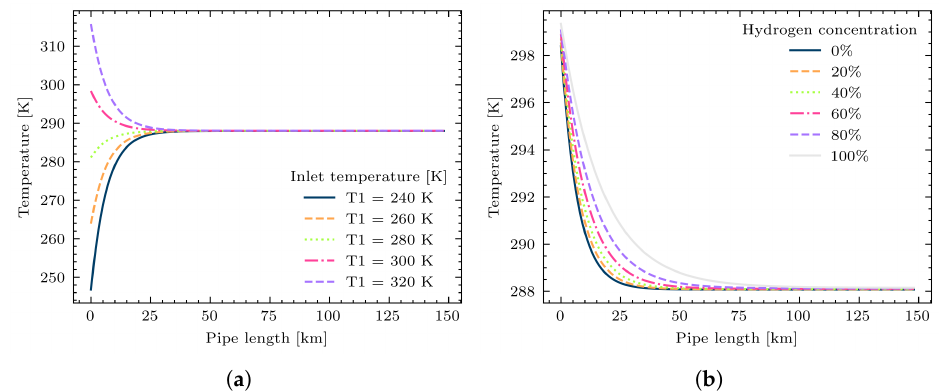
Figure 5. ( a ) Temperature profile throughout a gas pipe with different pipeline inlet temperatures. ( b ) Temperature profile throughout a gas pipe with different hydrogen concentrations.